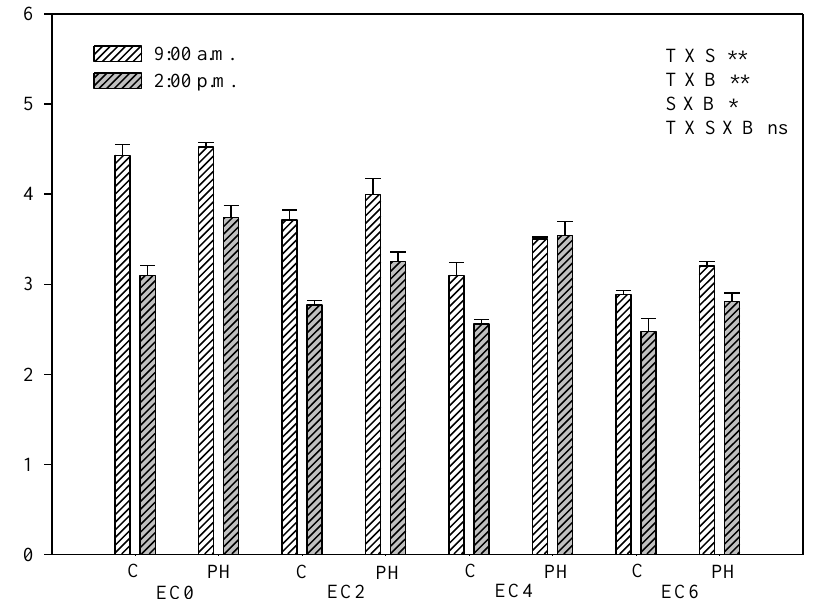
on plant photochemistry on a wider sensitivity scale (Figure 6).